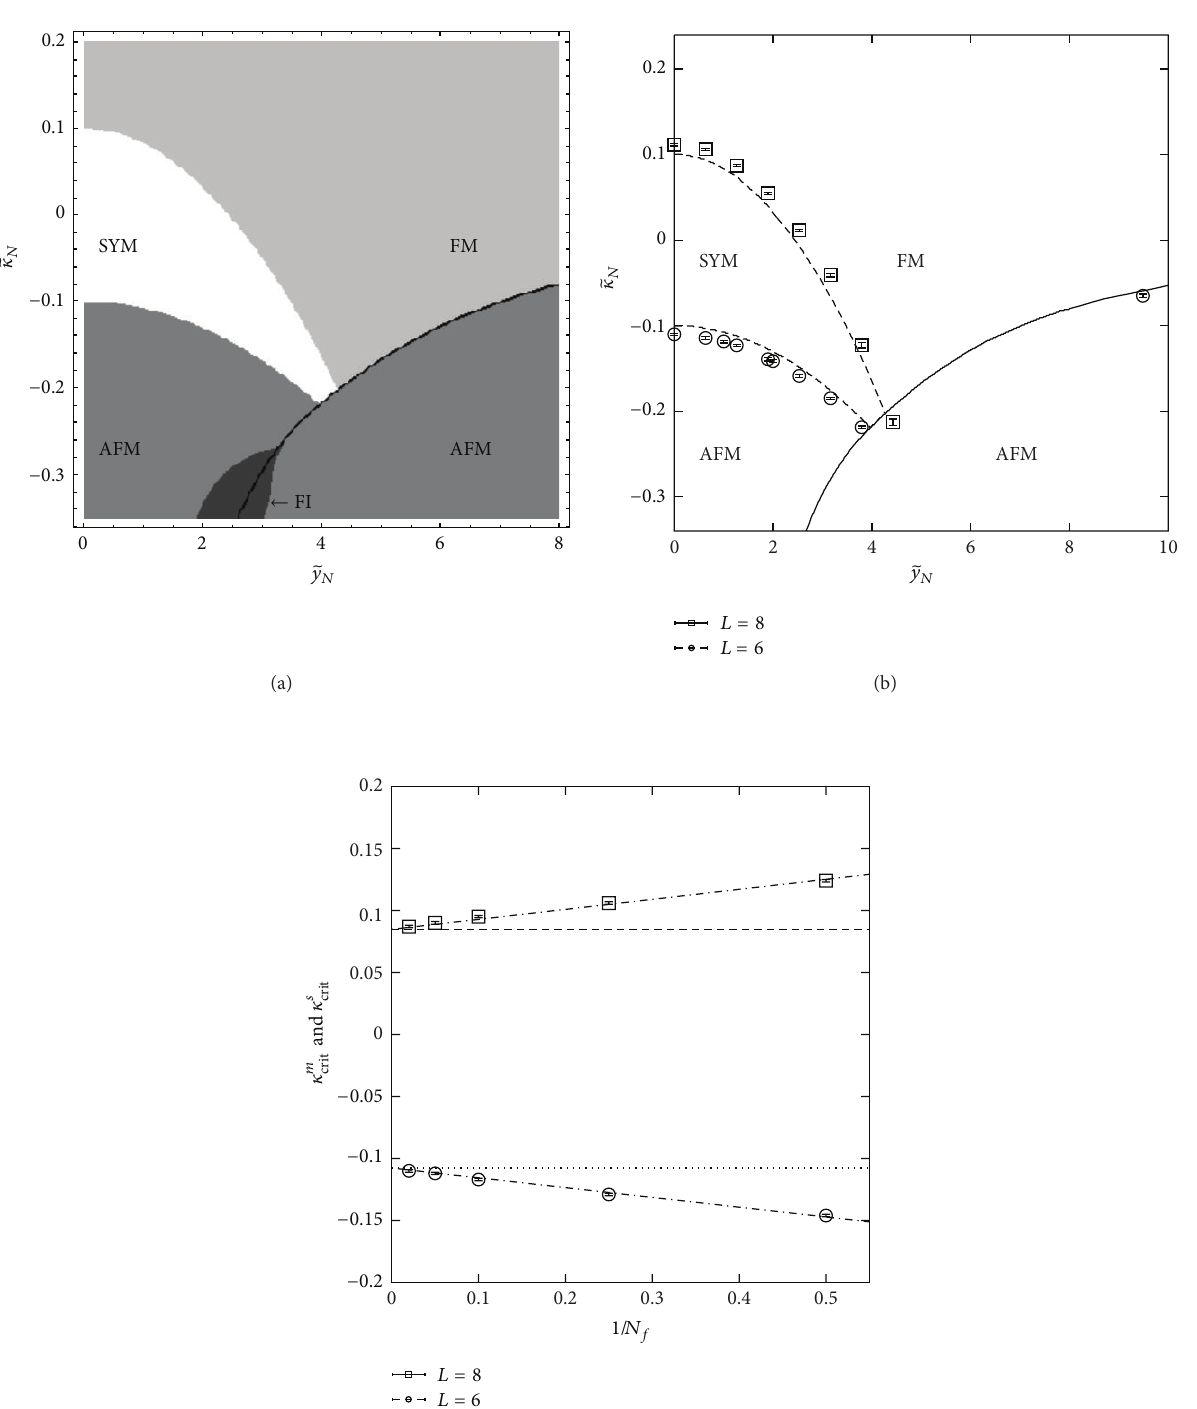
̃ 𝜆 = 0.1 . The black line indicates 𝑁 ( > 0) and 𝜅 𝑠 ( < 0), respectively. The squares and circles in crit crit